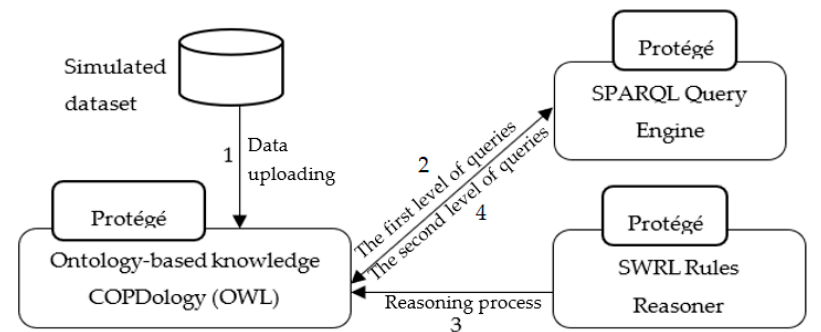
Figure 12. Flow in the implemented system.